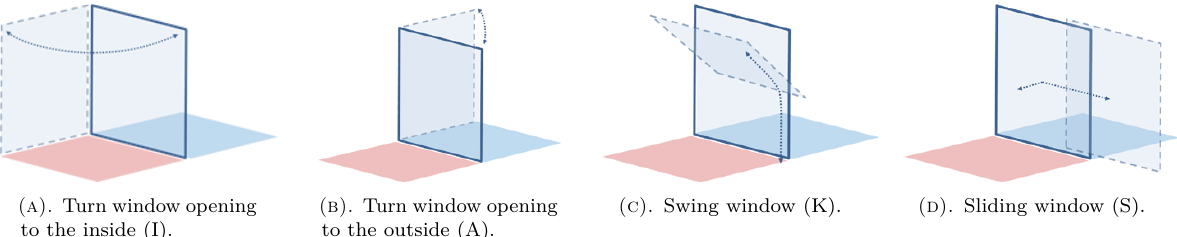
Figure 5. Selected operational window concepts elaborated in the FIVA project.